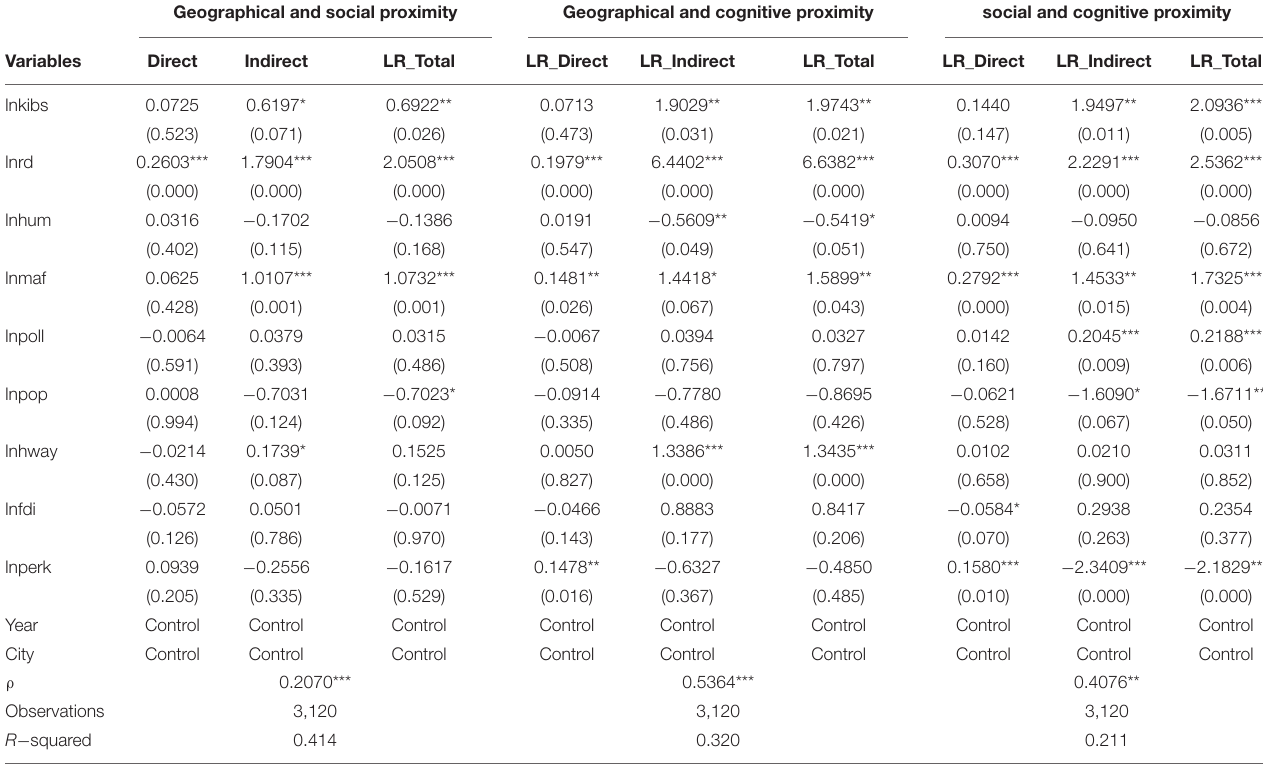
TABLE 4 | The regression tests under different proximity’s intersection weight matrix. Geographical and social